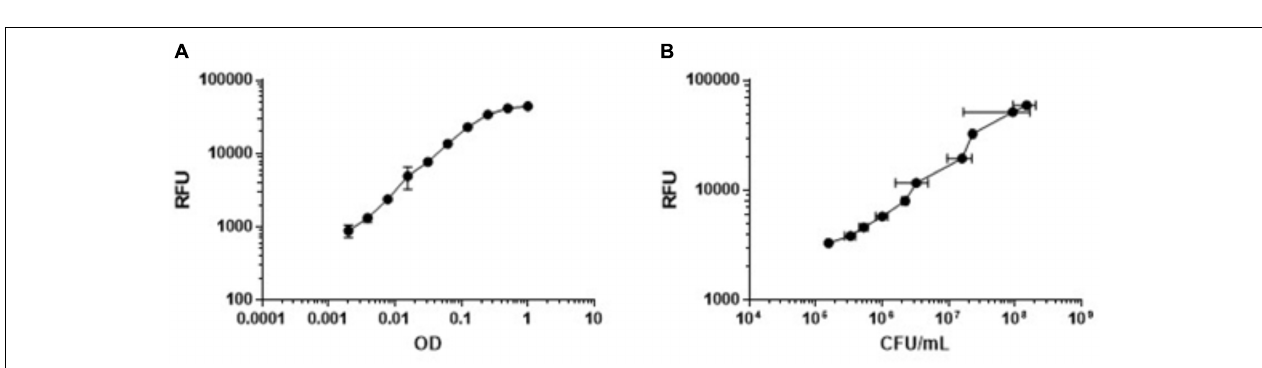
FIGURE 2 | Metabolic activity measured by alamarBlue R (cid:13) correlates with OD 590 and bacterial viability. Nutrient-starved bacteria were generated in PBS-Tyl. Bacteria were serially diluted twofold and metabolic activity was measured by alamarBlue turnover after 24 h (RFU). (A) OD was measured at 590 nm. (B) Bacterial viability was measured by determining CFU. Data are average ± SD of three